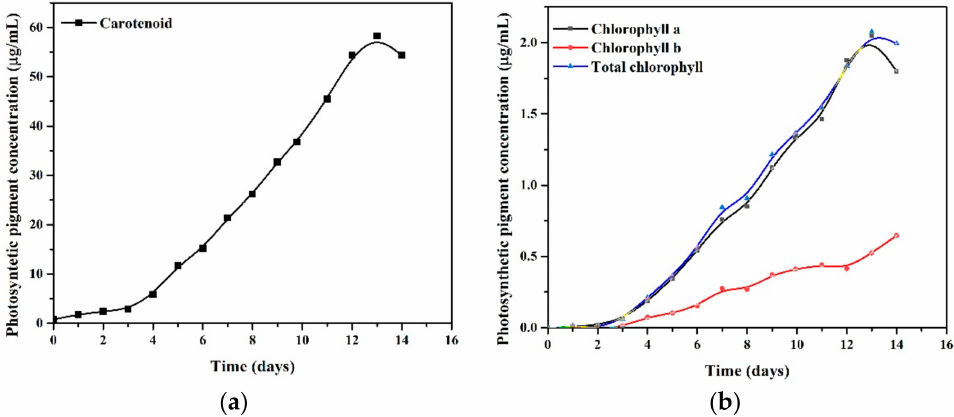
Figure 3. Photosynthetic pigment production ( µ g/mL): carotenoids ( a ) and chlorophyll-a, chlorophyll b, total chlorophyll, respectively ( b ), and throughout the 14-day experimental period (algal growth without